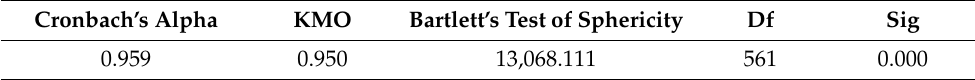
Table 1. Reliability and validity